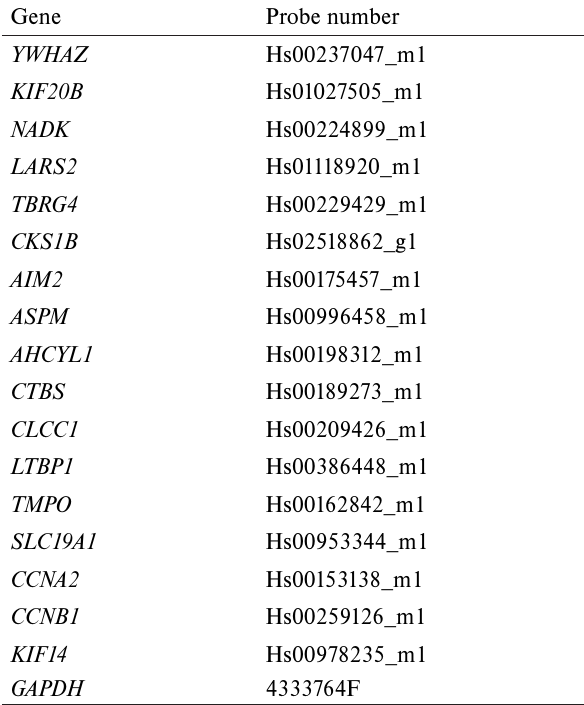
Table 2. List of probes (Applied Biosystems) used in the